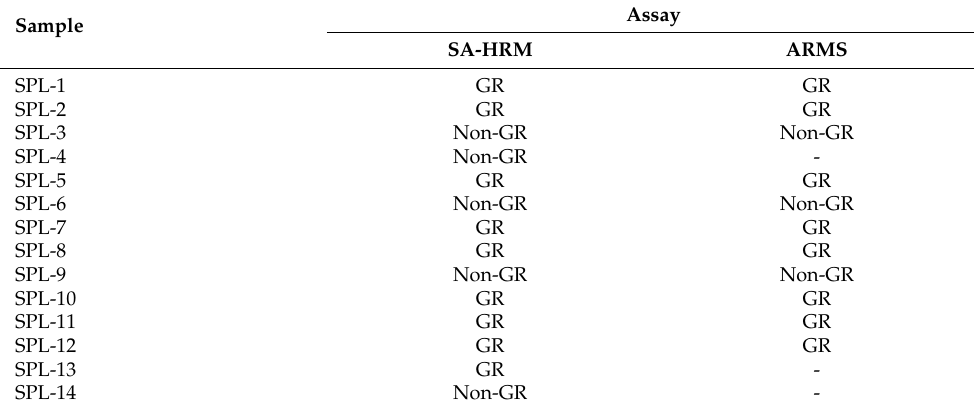
Table 4. Correlation of normalized optical density of bands resulting from the ARMS assay to concentration and purity of the RNA samples, as well as Ct values corresponding to real-time RT-PCR assays of the RdRp, E and N SARS-CoV-2 genes. r (Relative